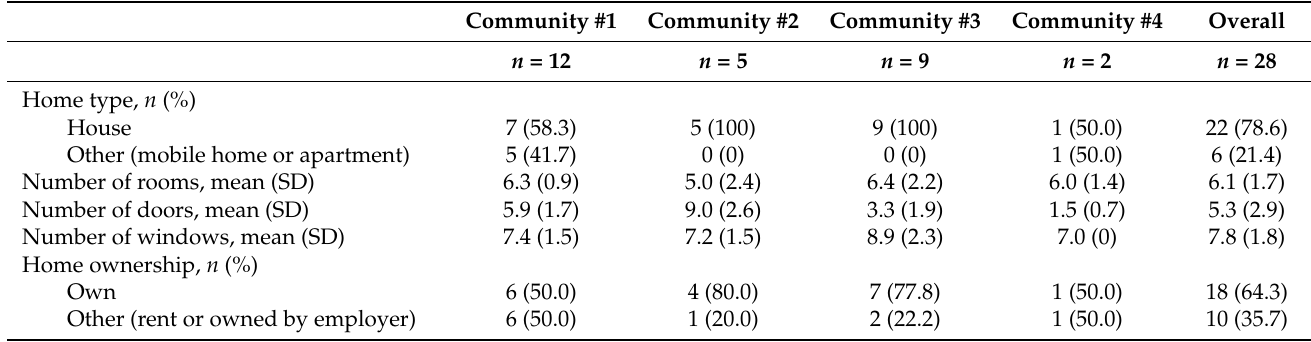
Table 1. Characteristics of households from which dust samples were analyzed for the presence of